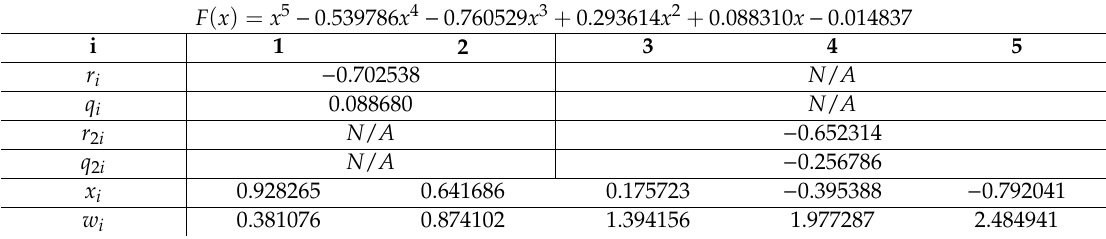
Table 7. The results of LSP frequencies of F ( x ) = 0 .